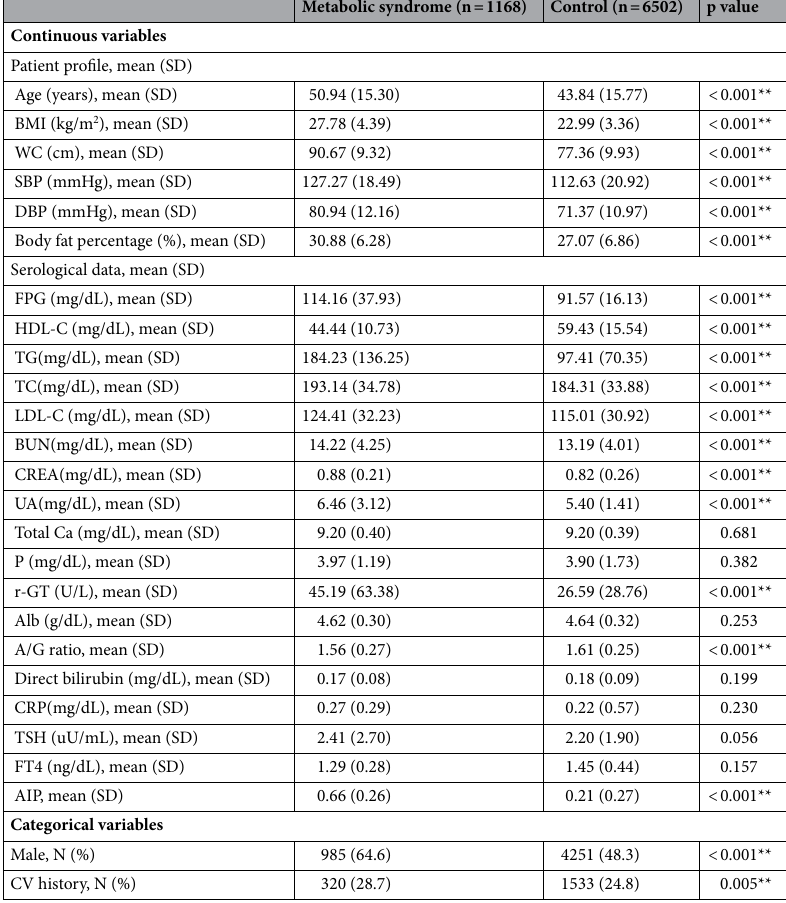
Table 1. Demographic data of participants with or without metabolic syndrome. BMI body mass index, WC waist circumference, SBP systolic blood pressure, DBP diastolic blood pressure, FPG fasting